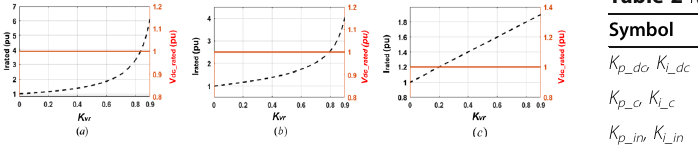
Fig. 6 DC-link cluster voltage and cluster current ratings of SDBC-STATCOM with respect to K vr at a Q F = 0, b Q F = 0.5 and c Q F = 1 with φ V- = 0 0